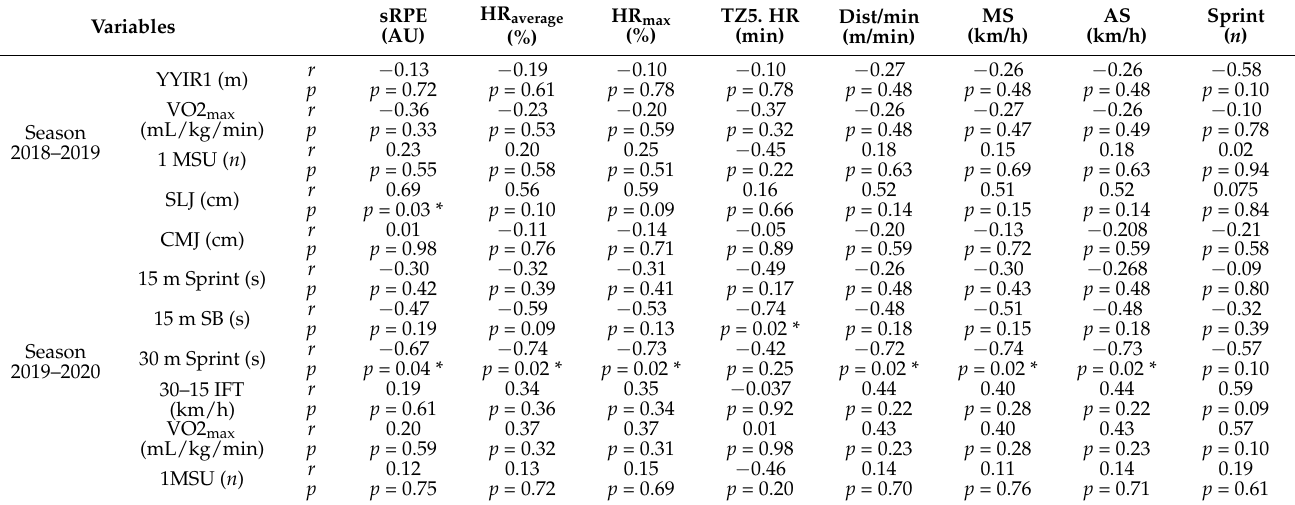
Table 8. Correlation between performance variables, locomotor demands, and physical fitness assessment for non-selected futsal